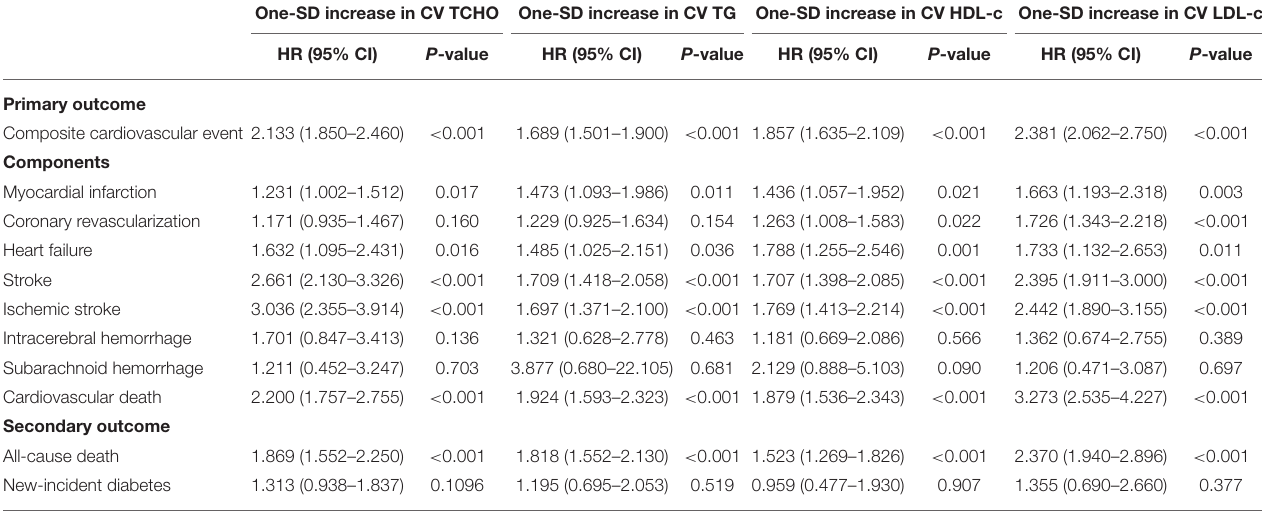
TABLE 4 | Cumulative hazards of outcomes with each one-SD increment in the CVs for lipids during the follow-up period. One-SD increase in CV TCHO One-SD increase in CV TG One-SD increase in CV HDL-c One-SD increase in CV LDL-c P